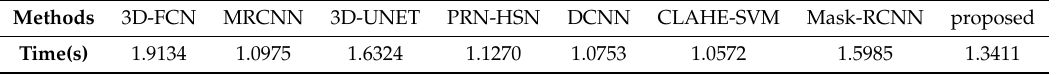
Table 11. The running time of applying different methods in detecting nodules.